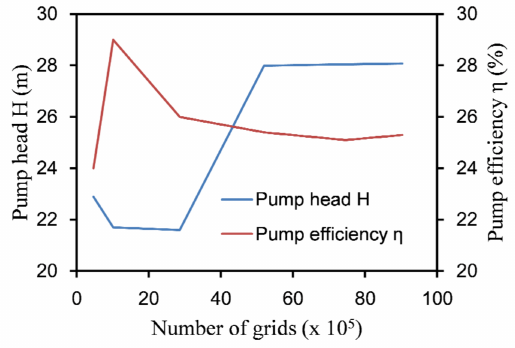
Figure 4. Grid independence